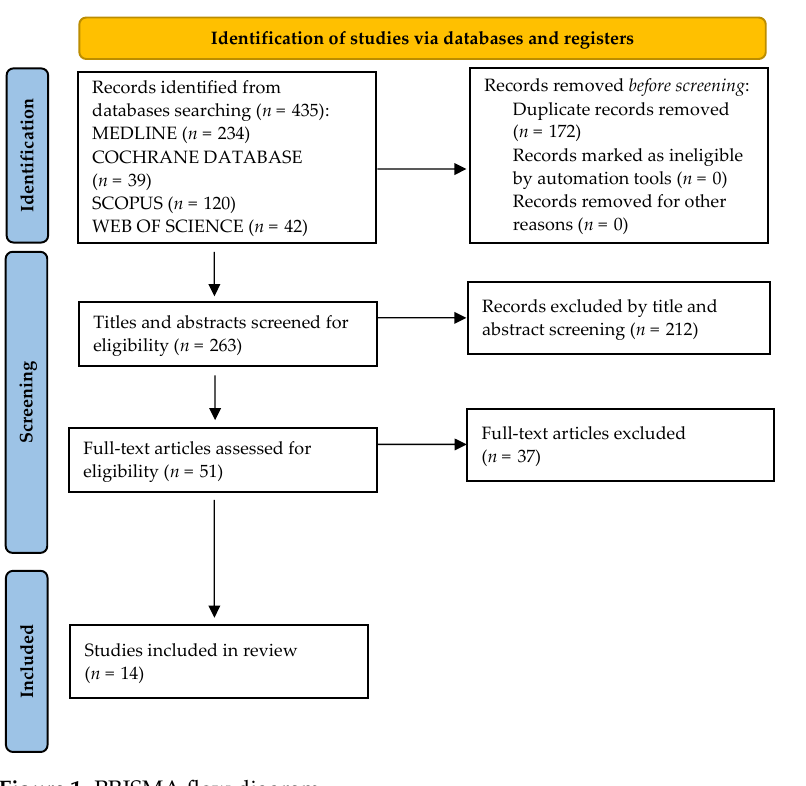
Figure 1. PRISMA flow diagram.